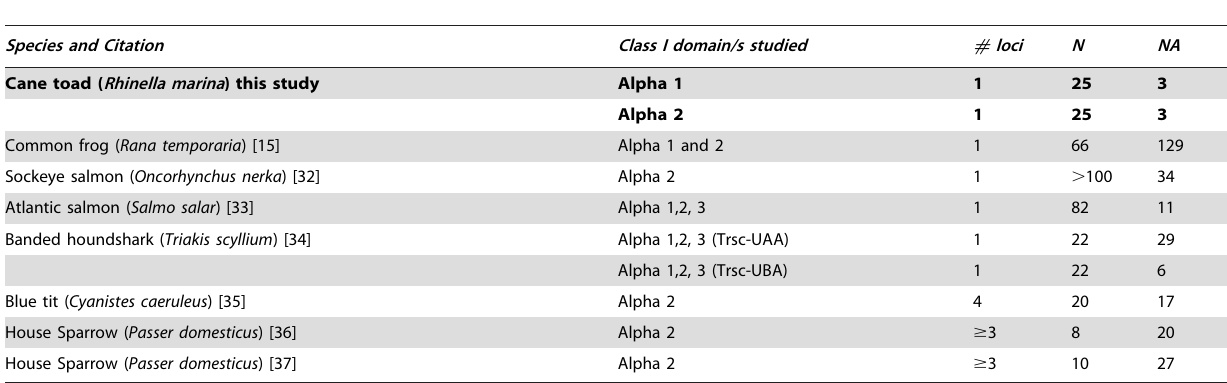
Table 3. Comparison of allelic diversity at the MHC class I (N is number of individuals studies and NA is number of alleles).